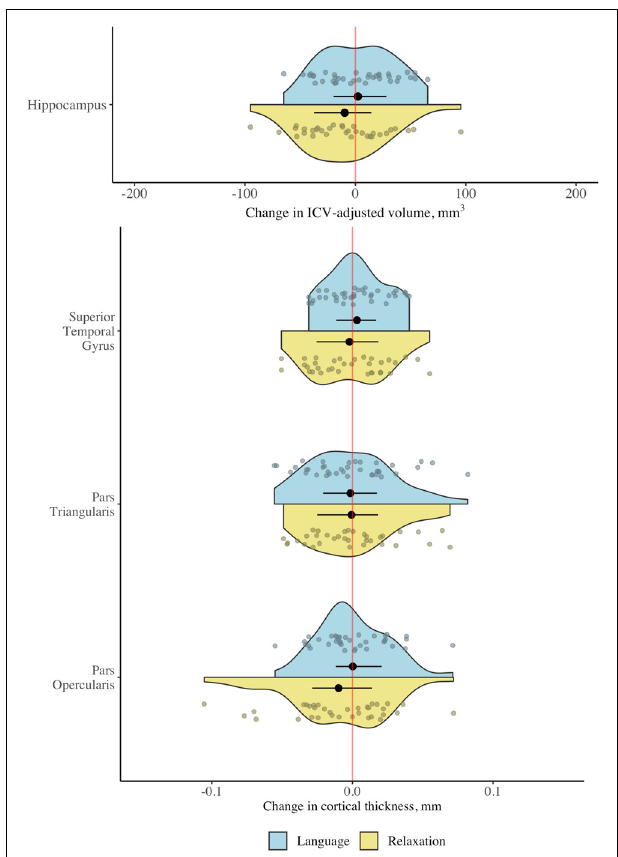
FIGURE 4 | Change in gray matter regions of interest following language and relaxation training. Distribution of change scores (post − pre) for cortical thickness and adjusted hippocampal volume in the language group ( n = 38) and the relaxation group ( n = 34). Black dots and line segments denote the mean and 1st and 3rd quartiles. Smaller dots denote individual change scores. Note that the scale is different for cortical thickness (mm) and volume (ICV-adjusted mm 3